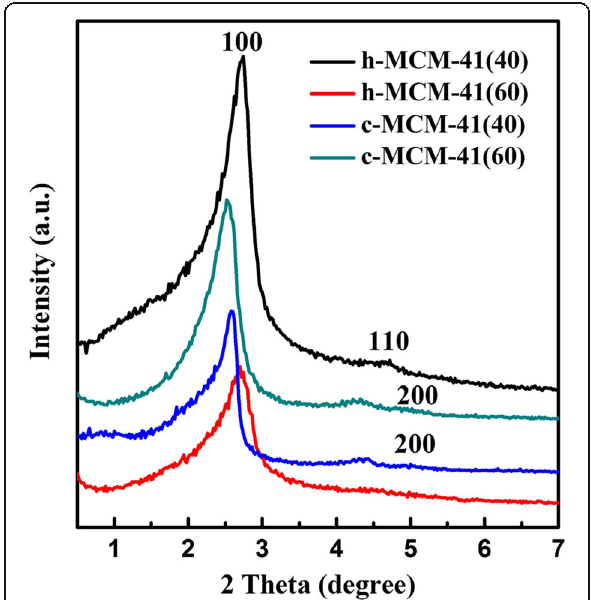
Fig. 2 XRD patterns of the samples prepared at different reaction times with HCl and citric